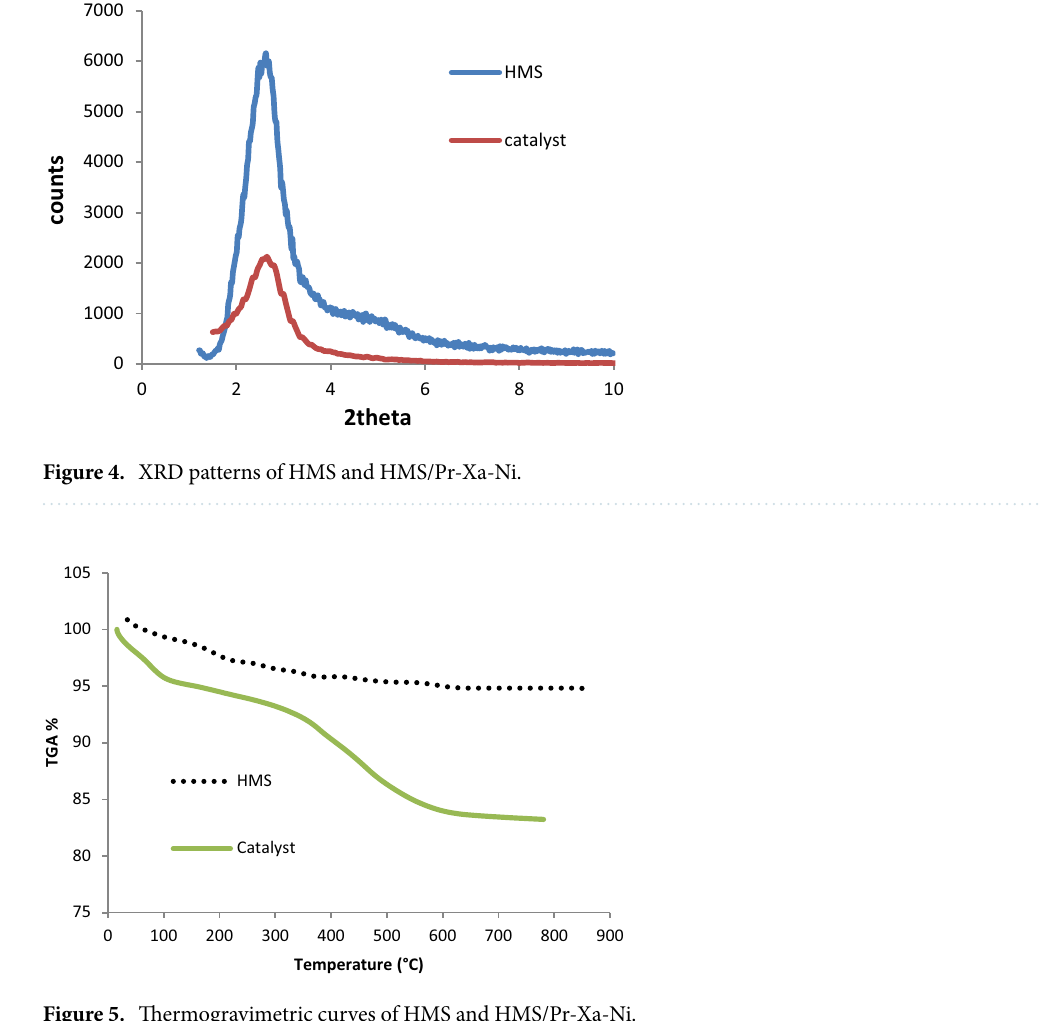
Figure 5. Thermogravimetric curves of HMS and